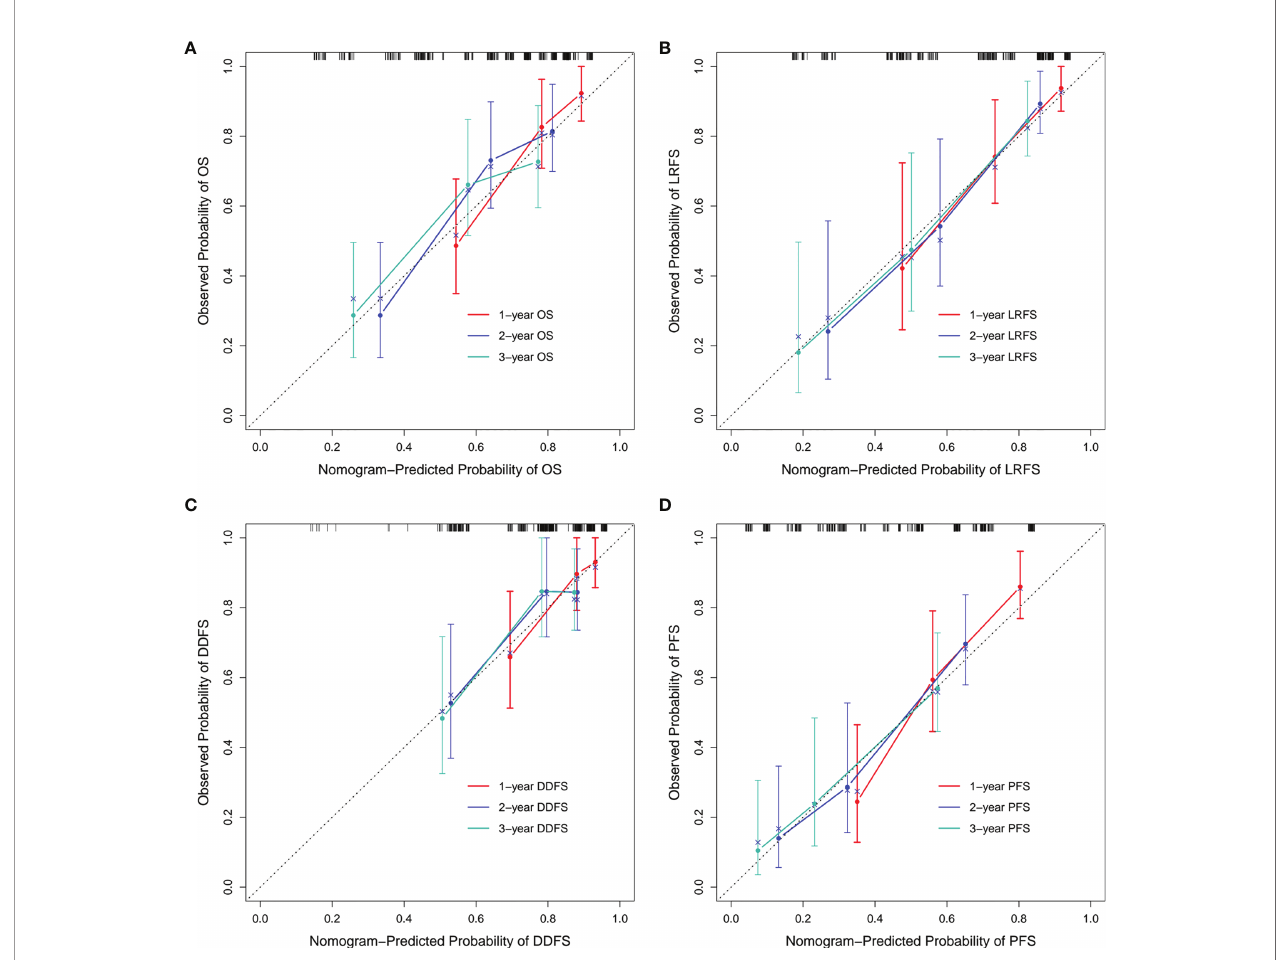
FIGURE 7 | Calibration curves of each nomogram model. The calibration curves of the 1-, 2-, and 3-year OS prediction nomogram (A) , LRFS prediction nomogram (B) , DDFS prediction nomogram (C) and PFS prediction nomogram (D) . OS, overall survival; LRFS, local recurrence free survival; DDFS, distant disease-free survival; PFS, progression free